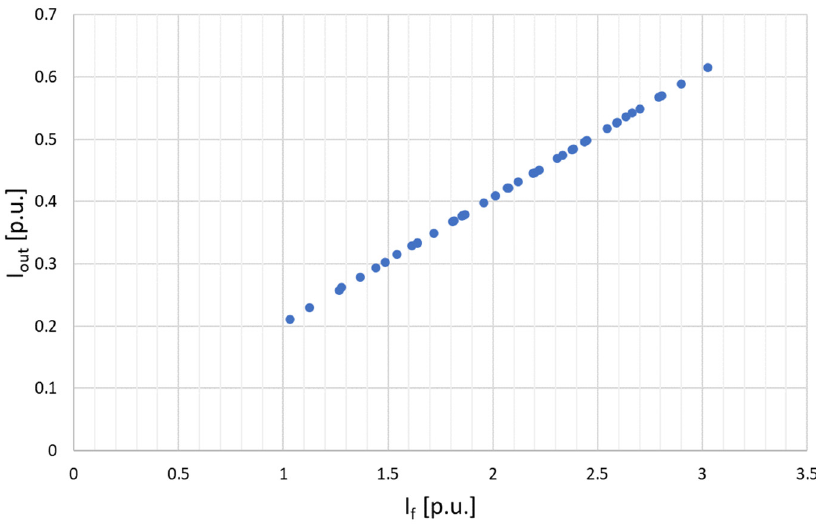
Figure 8. Relationship between I f (DC) and |I out | (AC rms) for the simulation model exciter.